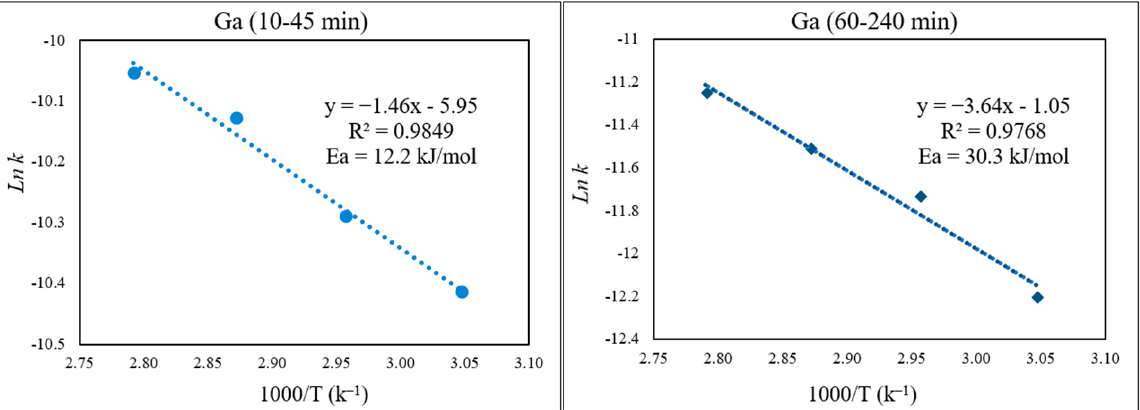
Figure 16. Arrhenius plot of ln k vs. 1000/T for Ga for the first part (10–45 min) and the second part (60–240 min) of the extraction.